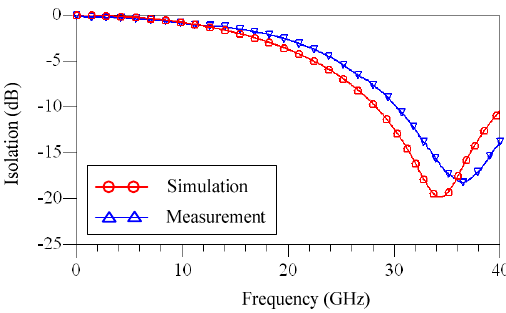
Figure 7. Simulation of isolation for the switch.